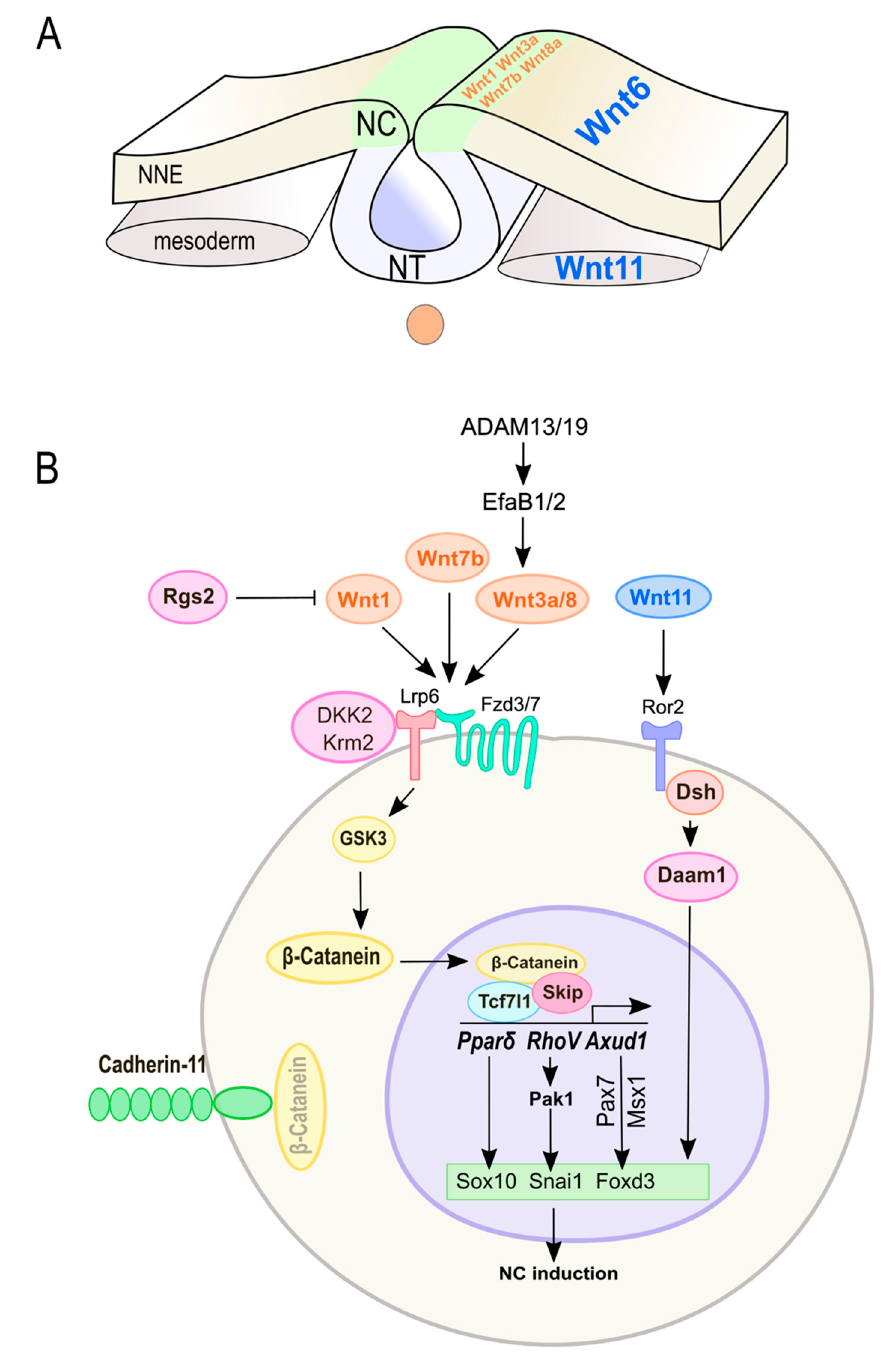
Figure 3. Wnt signaling induces neural crest cells by regulating NC specifiers. ( A ) NC is induced from the neural plate border at the end of gastrulation (zebrafish and Xenopus ) or the beginning of neurulation (chick and mouse). This process is regulated by both canonical ( orange ) and non-canonical ( blue ) Wnts secreted from NPB, adjacent NNE, and paraxial mesoderm. ( B ) Key components and possible interactions between Wnt signaling and NC specifiers. NC, neural crest; NNE, non-neural ectoderm; NT, neural tube.